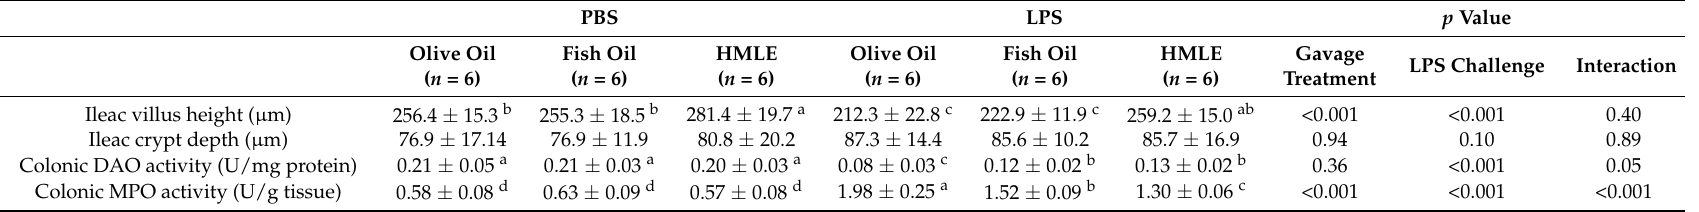
Table 3. Effects of different gavage treatments on ileac villus height and crypt depth and colonic DAO and MPO activity.